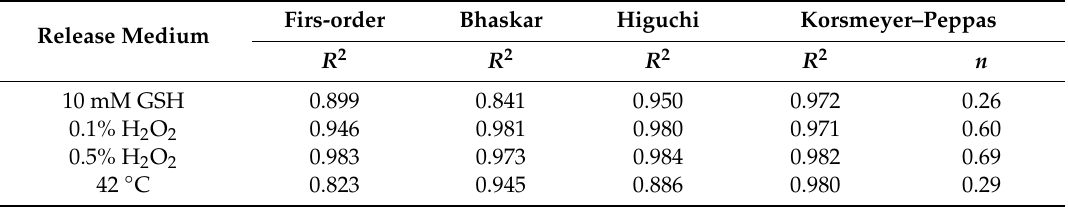
Table 3. Kinetic parameters of drug release in di ff erent